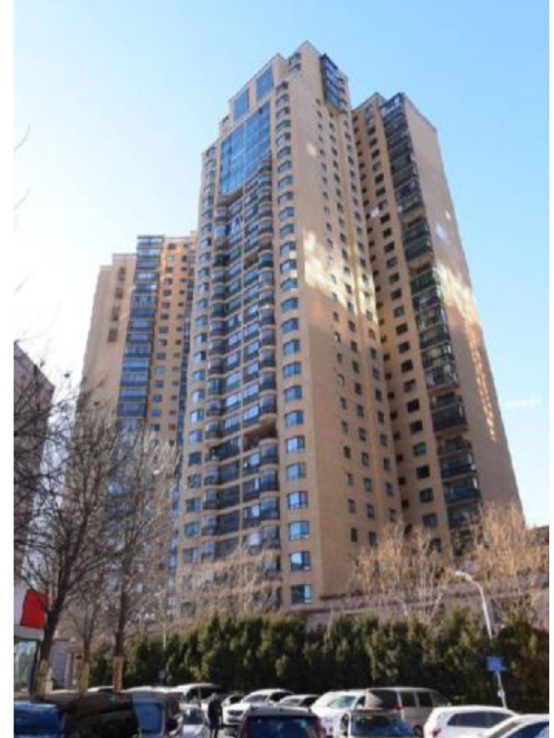
Fig. 7 Beijing Jiahe Liyuan International Apartment